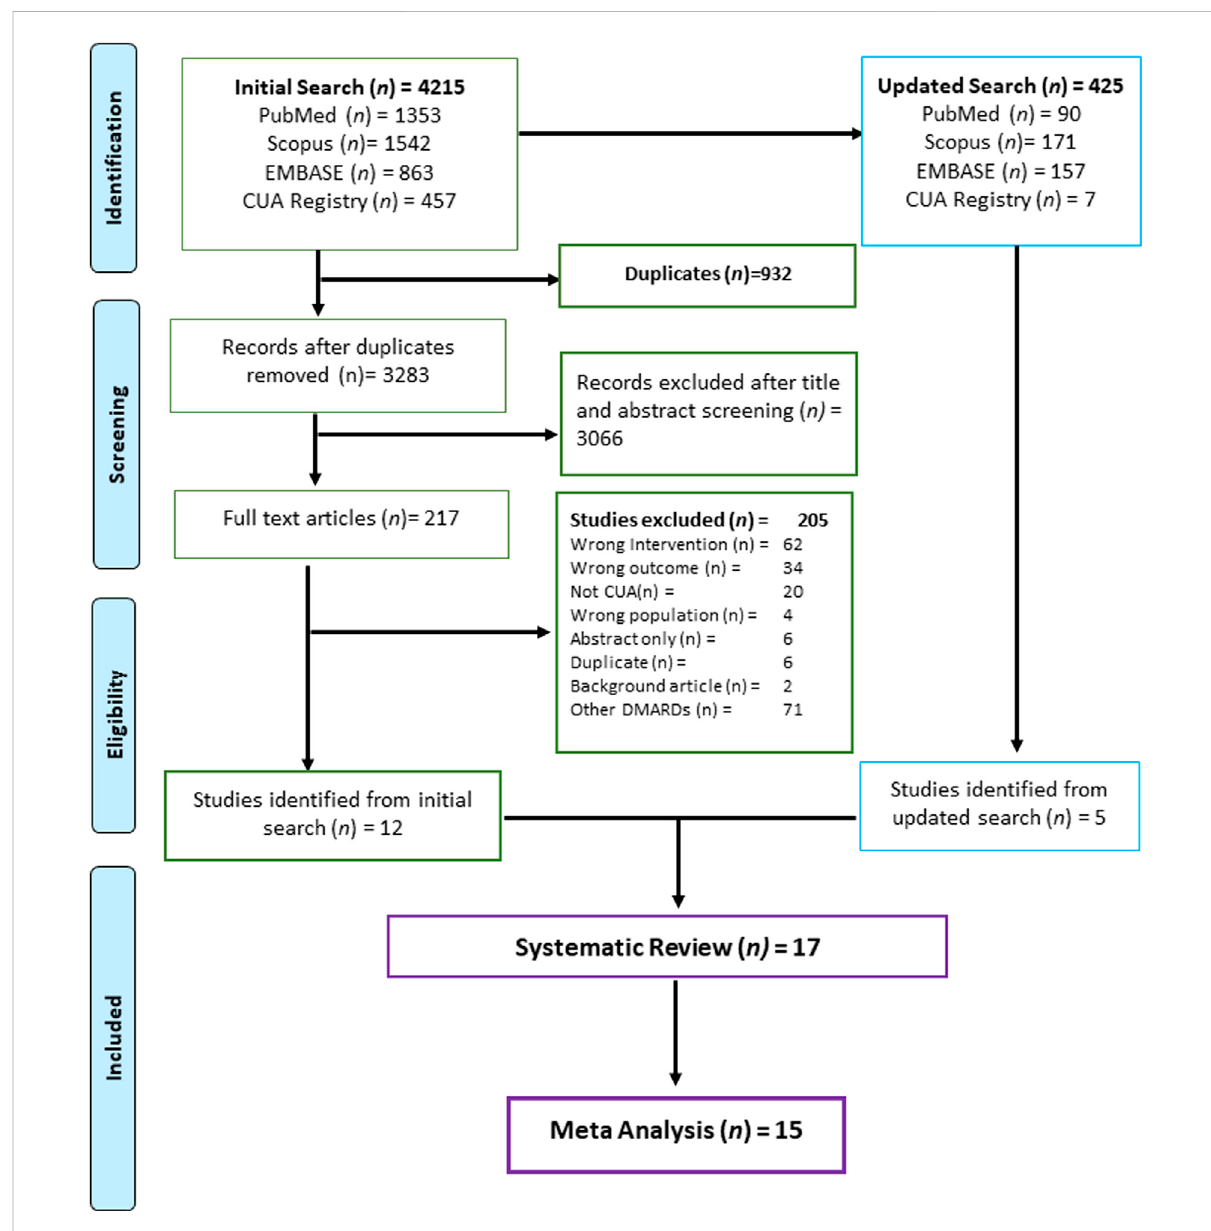
FIGURE 1 List of studies identi fi ed and included for systematic review and meta